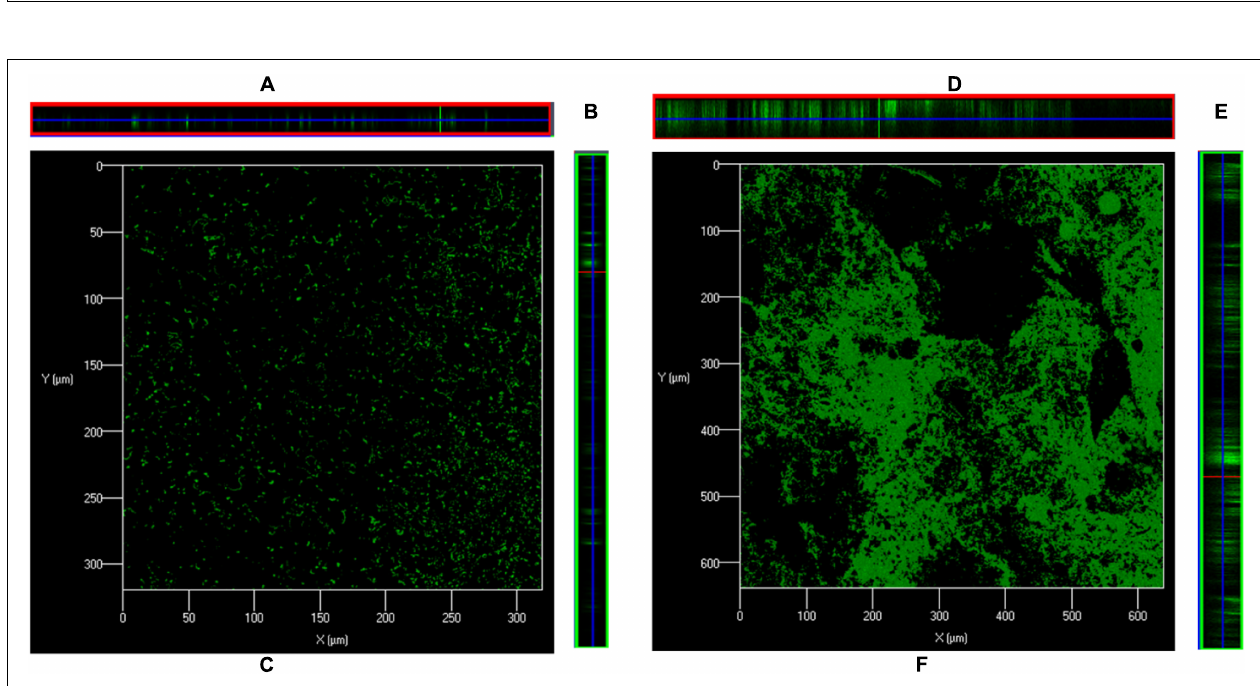
FIGURE 2 | Scanning electron microscope (SEM) images of S. pneumoniae D39 in vitro biofilms grown in metal ion-free medium for 48 h. (A–C) Representative SEM images of the S. pneumoniae biofilms grown without ASD (control). The control biofilms were thin and unorganized, bacteria formed long chains, and cell size was smaller than normal. (D–F) SEM images of the S. pneumoniae biofilms grown in the presence of ASD particles (300 µ g/ml). The bacteria formed compact biofilms and were attached to each other, and the cell size appeared normal. Images from left to right are 20, 10, and 5 µ m, respectively.